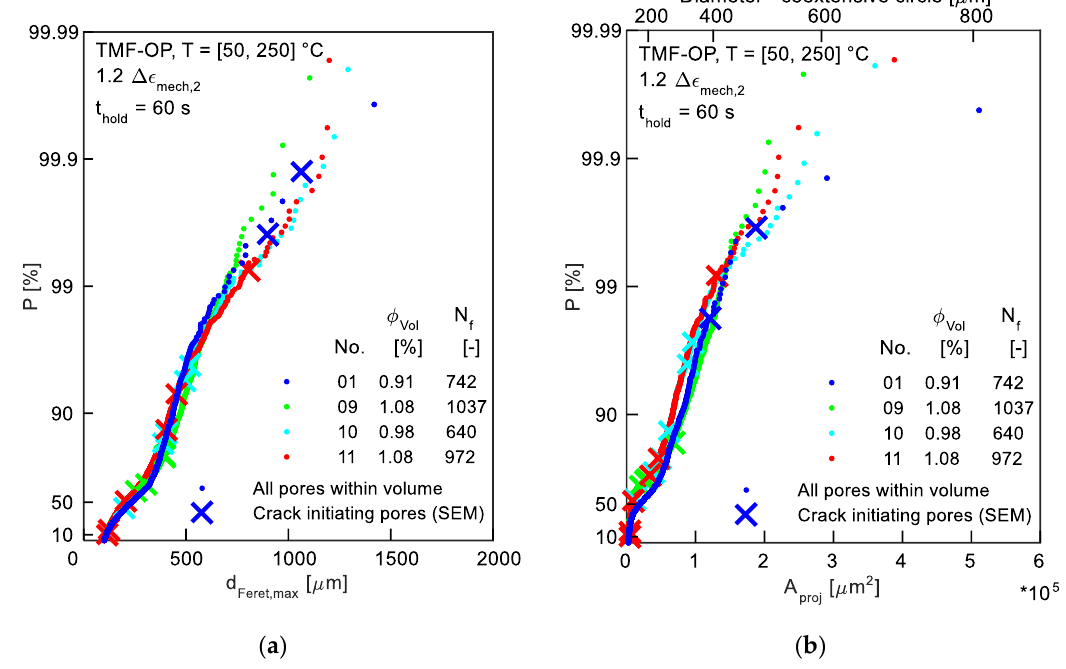
Figure 10. Characteristic parameters in probability plot of exponential distribution for specimens which were TMF tested at 1.2 Δε mech,2 and T max = 250 °C—crack-initiating pores detected by SEM are shown by the crosses. ( a ) d Feret,max ; ( b ) A proj .